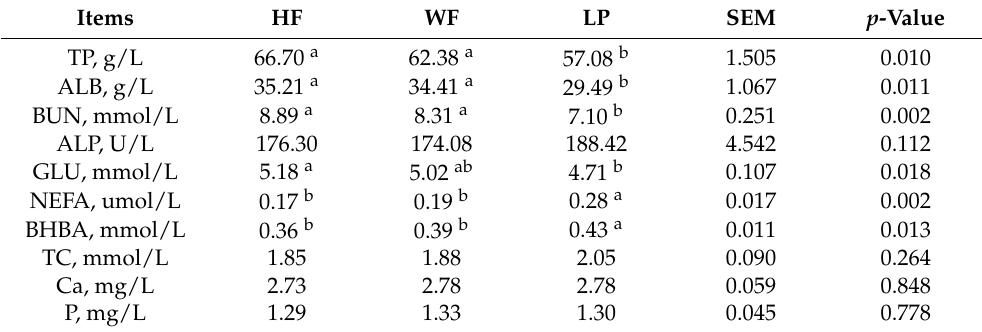
Table 4. Effects of dietary crude protein levels on serum metabolites of lactating